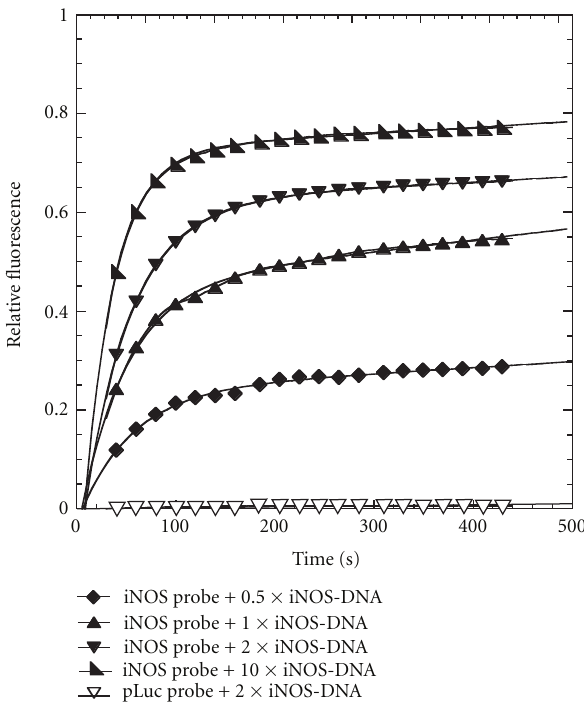
Figure 4: Kinetics of fluorescence activation of the strand-dis- placement probes by iNOS-DNA. Fluorescence emission at 525 nm of the iNOS probe (0.2 μ M FAM-iNOS-PNA annealed to 0.4 μ M iNOS-DNA-DABCYL) or the pLuc probe (0.2 μ M FAM-pLuc-PNA annealed to 0.4 μ M pLuc-DNA-DABCYL) in the presence of the indicated amount of iNOS-DNA. Excitation wavelength